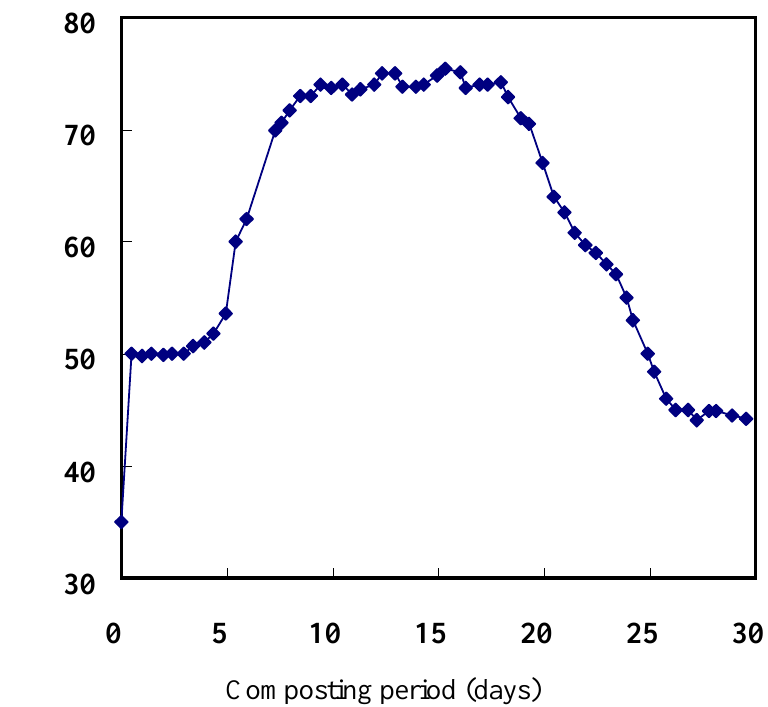
Figure 3. Temperature variation during the composting